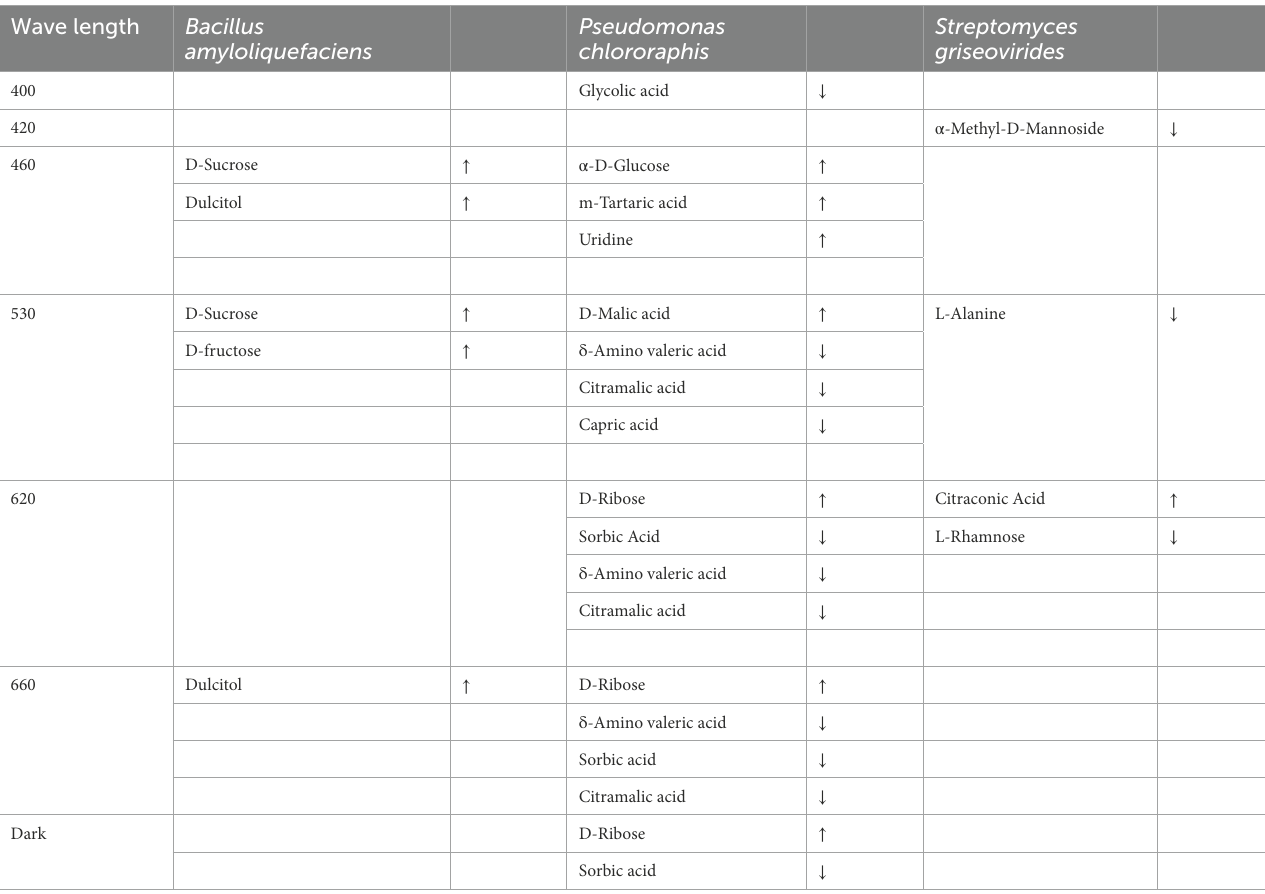
TABLE 2 Directionality of biofilm formation by Bacillus amyloliquefaciens , Pseudomonas chlororaphis , and Streptomyces griseoviridis in the presence of selected sole carbon sources under exposure to different light regimes (light intensity: 50 μ mol s − 1 m − 1 : monochromatic LED: 400, 420, 460, 530, 620, and 660 nm;